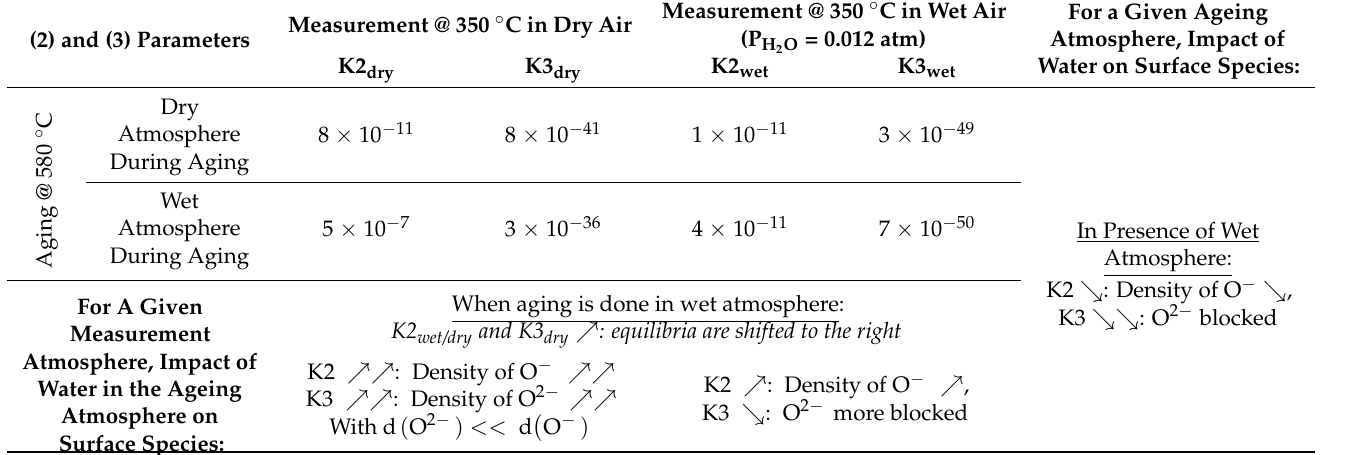
Table 1. Summary of equilibrium constants of oxygen adsorption under dry and wet atmosphere at 350 ◦ C and the effect of ageing under dry and wet atmosphere at 580 ◦ C on those parameters. Values of those parameters have been extracted from Suematsu et al.